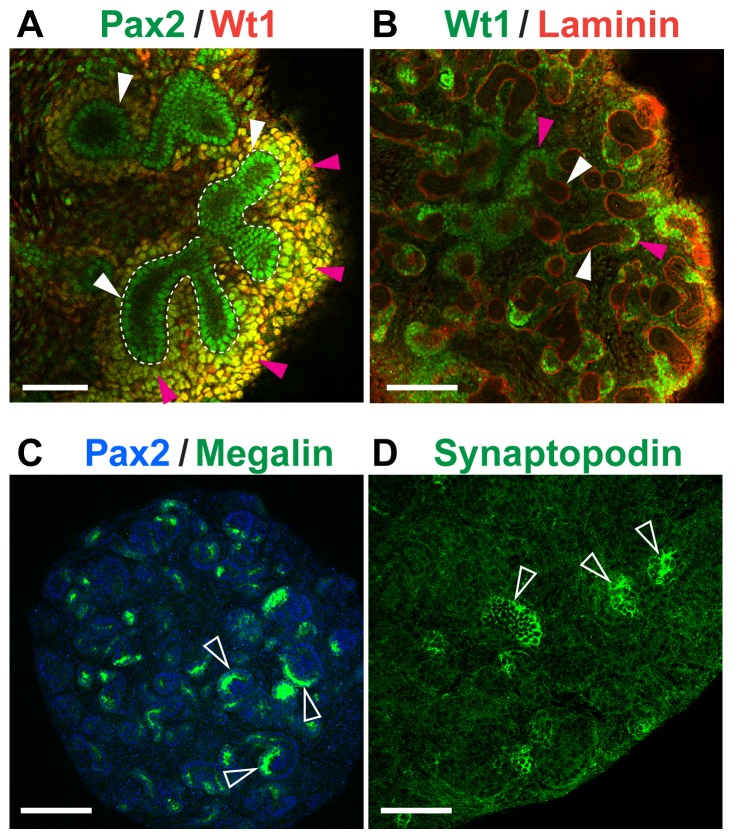
E11.5 re-aggregated kidneys form organotypic renal structures.(A, B) Immunostaining for Wt1 (red) and Pax2 (green) (A), or Wt1 (green) and laminin-111 (red) (B) shows the presence of condensed MM (pink arrowheads) surrounding the UB (white arrowheads) after 3 days of culture, thus demonstrating that the induction of the mesenchyme had taken place. (C) Immunostaining for megalin (green) and Pax2 (blue) at day 3 of rudiment culture reveals the presence of proximal tubules (open arrowheads). (D) Immunostaining for synaptopodin (green) demonstrates the presence of nascent podocytes within developing glomerular structures (open arrowheads) at 5 days of culture. Scale bars are 75 µm (A), 150 µm (B, C) and 100 µm (D).